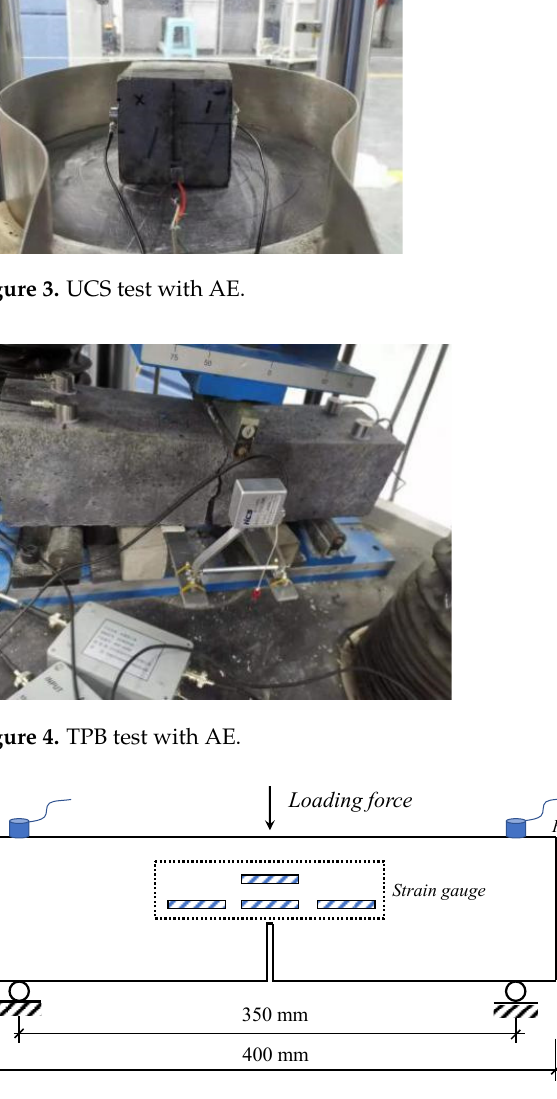
Figure 5. Schematic diagram of the three-point bending test of concrete beam with precast notch. During the loading processes of uniaxial compressive test and three-point bending test, DHDAS dynamic data acquisition and analysis system were used to collect the strain;